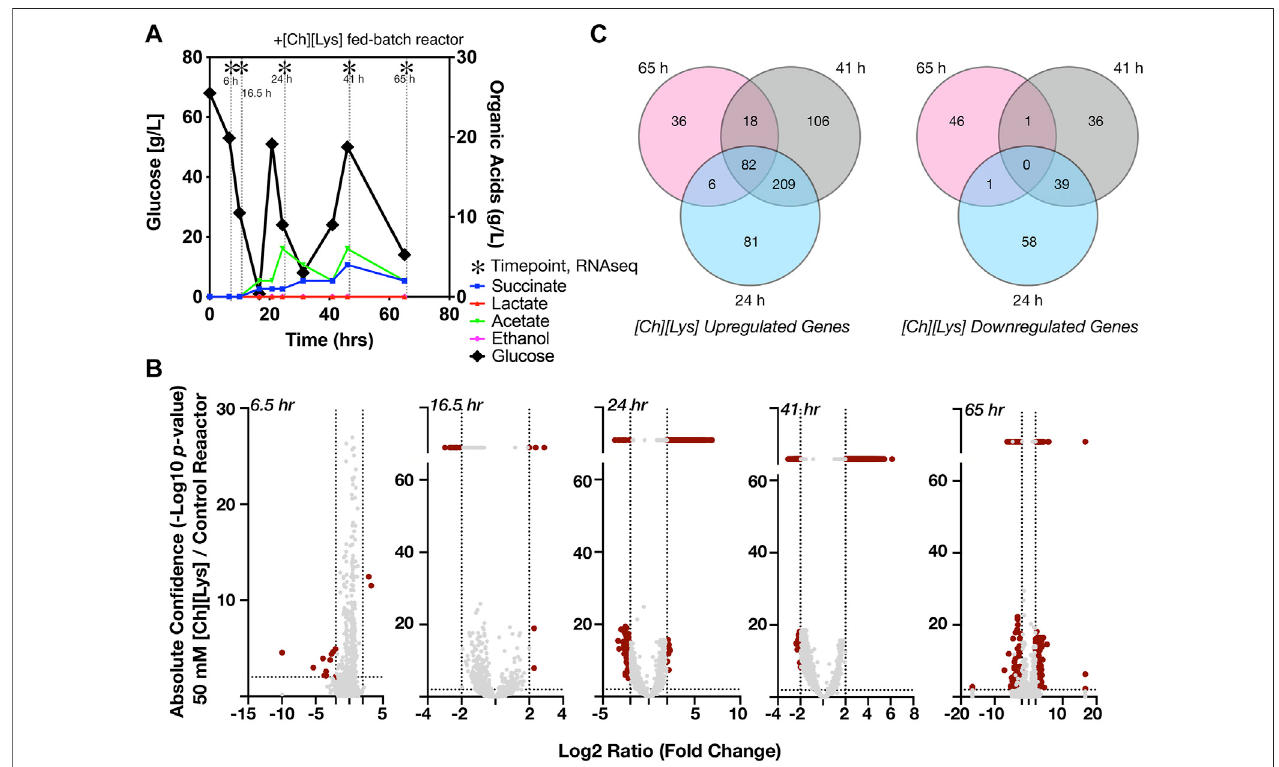
FIGURE 5 | Differential expression of genes in response to 50 mM of [Ch][Lys], (A) HPLC analysis of glucose and organic acids detected in the 2-L stirred tank bioreactorofcellsgrowninthepresenceofaninitialconcentrationof50 mM[Ch][Lys].Cellswereharvestedfromtheindicatedtimepointswith(*).Referto Figure4A for thecontrolbioreactor.Theglucoseandorganicacidvaluesforthetimecourseinthis fi gurepanelhavebeenpreviouslydescribedinEngetal.,2020, (B) Volcanoplotsof differentiallyexpressed genesforeachtime point.Geneswhichhave con fi dencevaluesorlog 2 ratios greaterthanthemaximum valueoneach axisareplottedona discontinuous portion of the axis as indicated with a line break. c) Shared and unique differentially expressed genes in response to [Ch][Lys]. Very few differences were detected in the 6 and 16.5 h time points and are not included in the Venn diagram. DEG was calculated as the ratio between the treated reactor and its corresponding time-matched sample in the other control reactor. Venn diagrams indicate the number of upregulated ( left) and downregulated ( right) genes at the indicated time